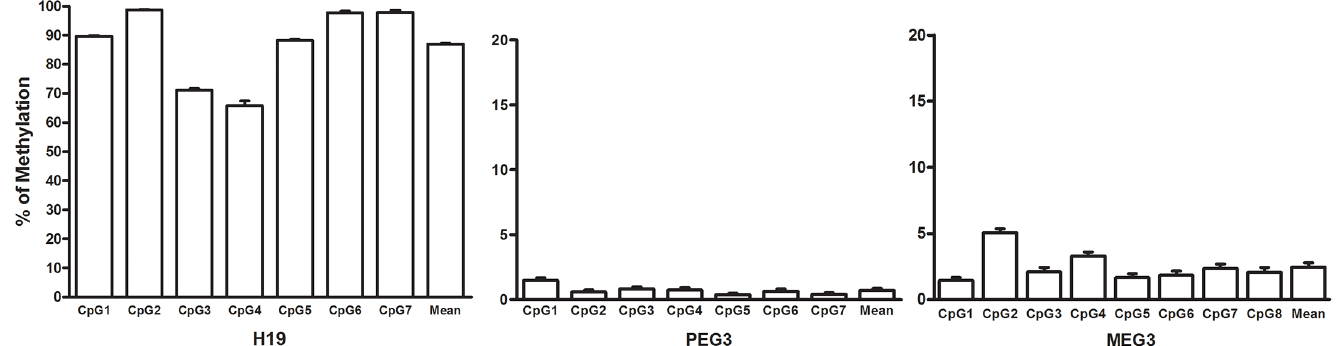
Fig 1. Levels of sperm DNA methylation at the DMRs of imprinted genes. The Bars represent percent of methylated cells by individual CpG site for each DMR of imprinting gene: H19 , Peg3 and Meg3 as indicated. The results are the means ± SEM of 242 human sperm samples.